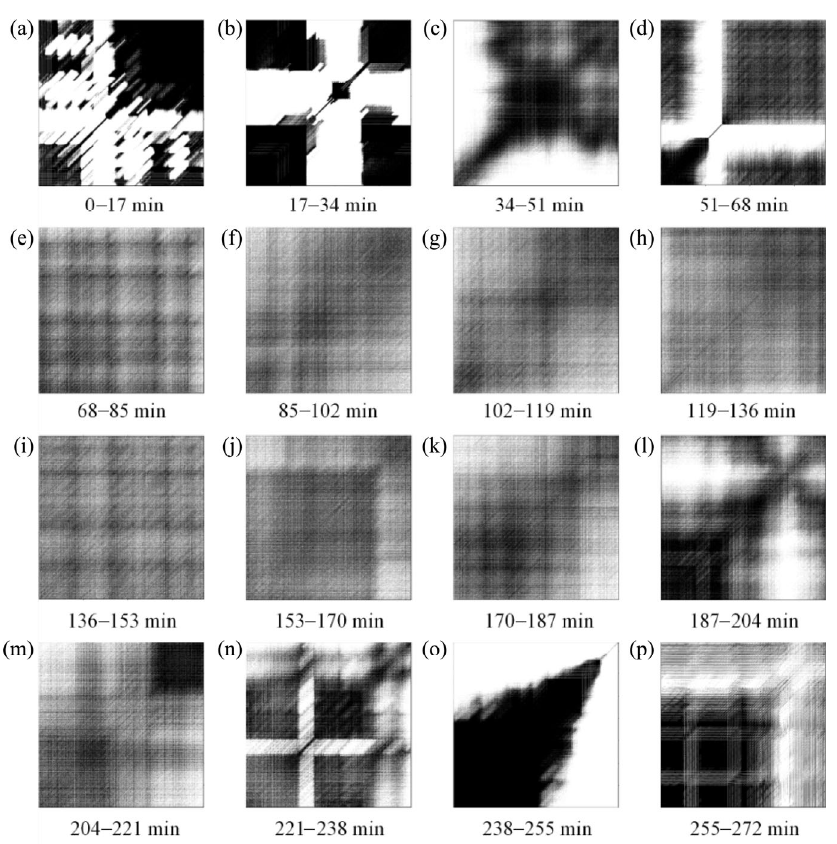
Fig. 7 Evolvement of RPs of the COF signal of Test 2 during the friction